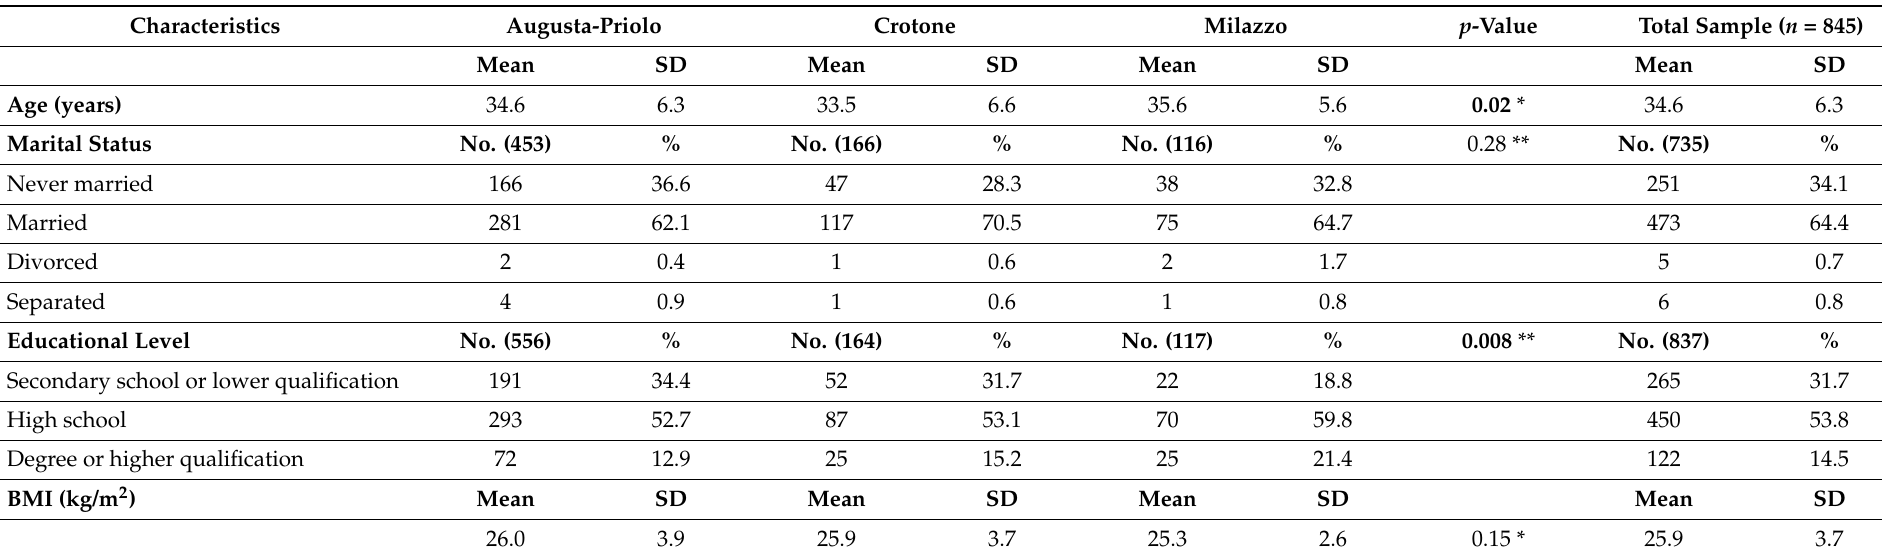
Table 2. Characteristics of fathers in the total sample and in each NPCS: continuous variables are reported as mean ± SD, while categorical variables are reported as numbers and percentages. Significant p -values are in bold. For each categorical variable, in parentheses, the total number of responders is